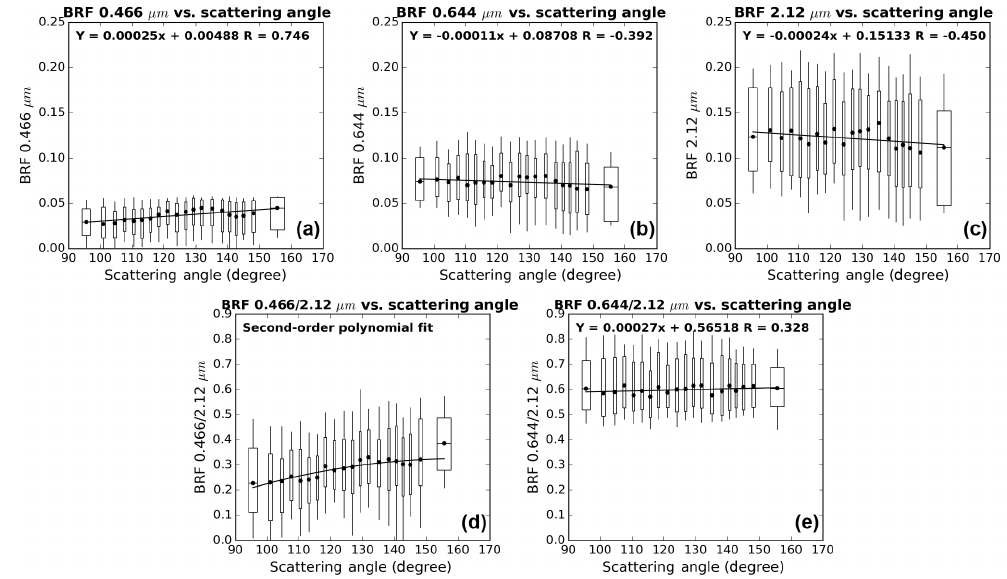
Figure 4. The dependence of the spectral BRF on the scattering angle. The dataset (2739 cases) with the dark surface are sorted and grouped into 20 bins by the scattering angle. Each bin has around 140 cases. On all subplots, dot, the height of box and the length of whisker for each bin indicate the median value, 1 σ and 2 σ of the reflectance or ratios, respectively. The width of box means 1 σ of the scattering angle for each bin. The first row shows the surface BRF at each wavelength (0.466, 0.644 and 2.12µm) as a function of the scattering angle. The second row shows the ratios of the surface BRF 0.466 / 2.12 and 0.644 / 2.12 as a function of the scattering angle.